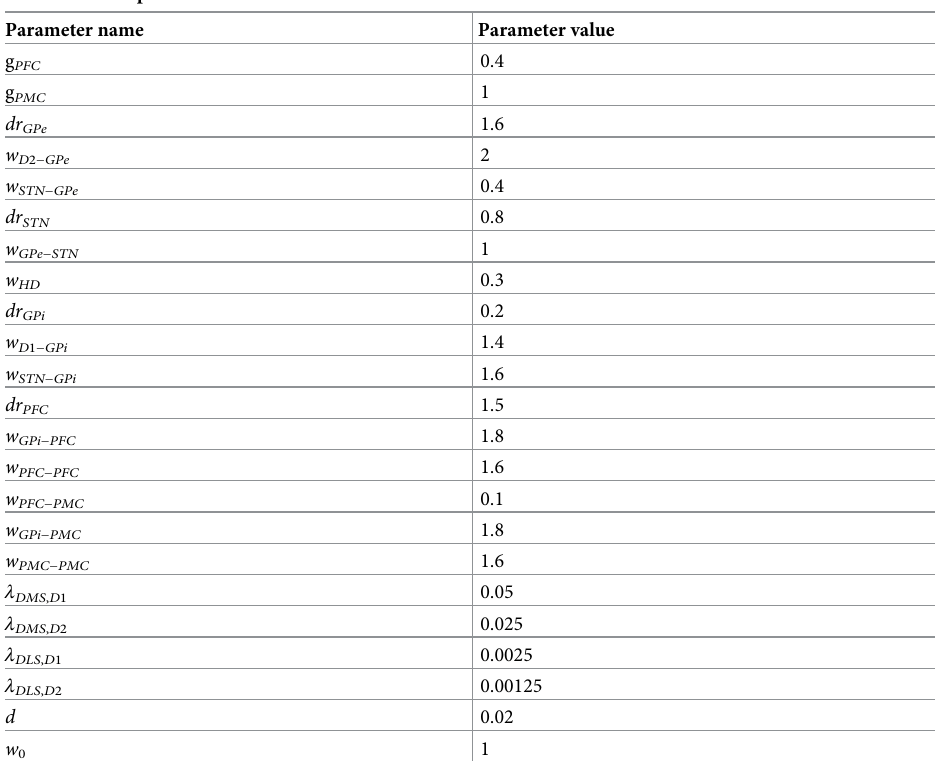
Table 3. Model parameter